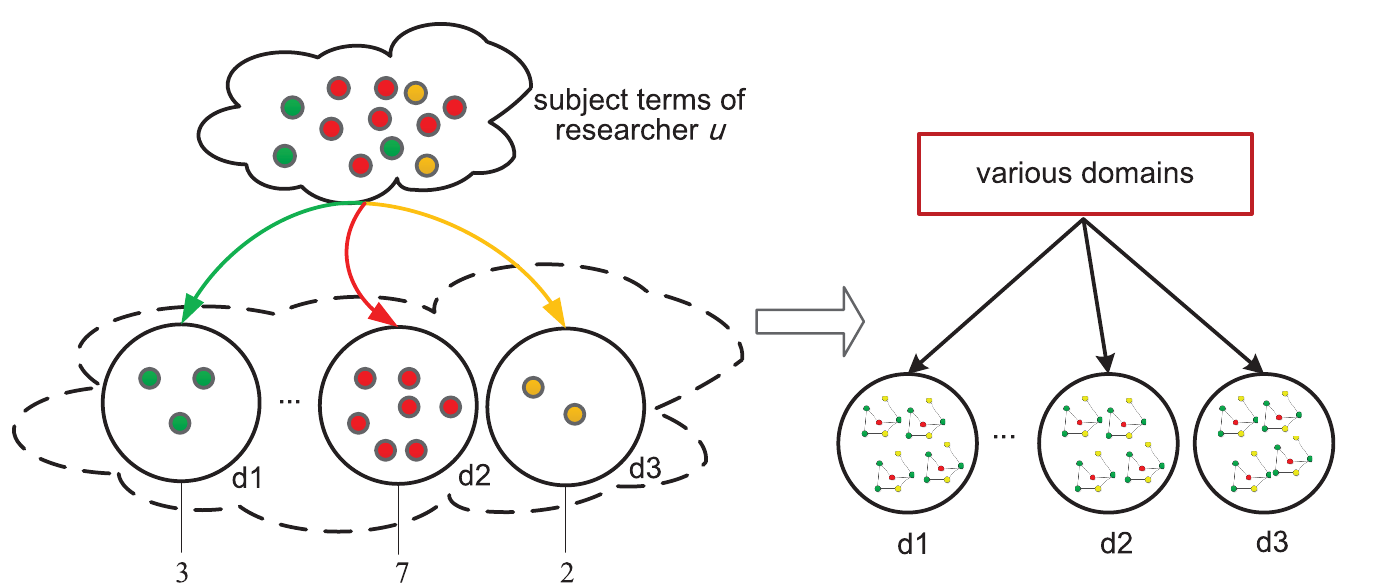
Fig 2. Researcher Partition. Illustrates an example of partition researchers to several